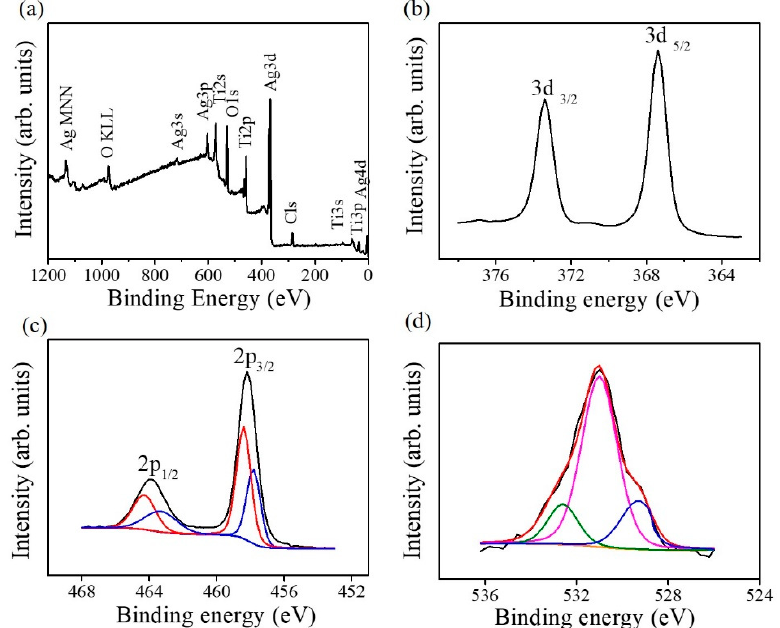
Figure 6. XPS analysis of the TiO 2 –Ag 2 O-1 composite nanorods: ( a ) Survey scan spectrum. ( b ) Ag 3d narrow scan spectrum. ( c ) Ti 2p narrow scan spectrum. The red curve is associated with the contribution of the Ti 4 + valance state and the blue curve originated from the Ti 3 + valence state. ( d ) O1s narrow scan spectrum. The blue and pink curves are ascribed to the lattice oxygen in Ag 2 O and TiO 2 , respectively. Moreover, the green curve is ascribed to external absorbed − OH groups or water molecules on the surfaces of the composite nanorods.